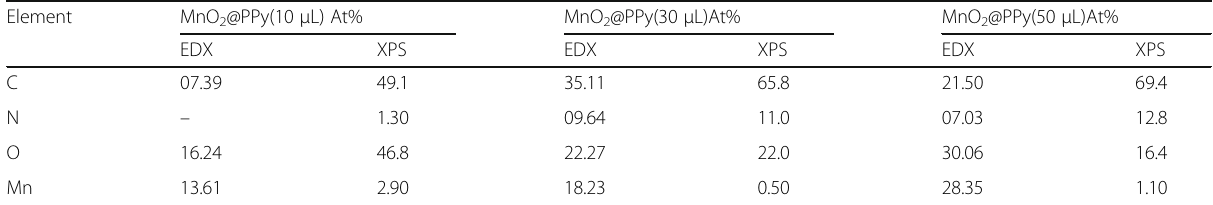
Table 2 XPS data for urchin-like MnO 2 @PPy sample Element